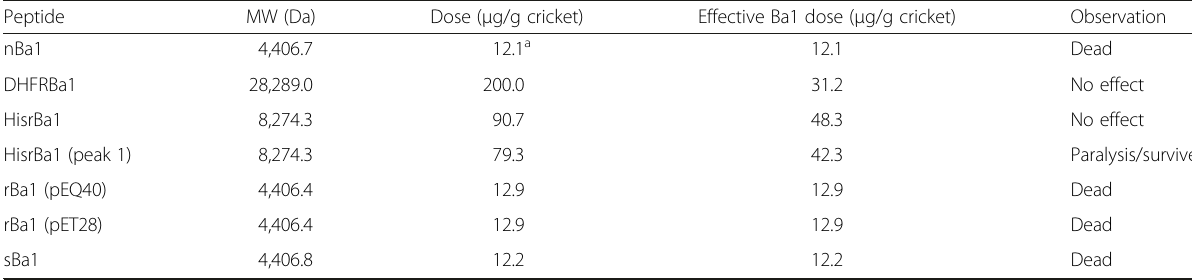
Table 1 Insecticidal effects of nBa1, DHFRBa1, HisrBa1, rBa1 and sBa1 on house crickets Peptide MW (Da) Dose ( μ g/g